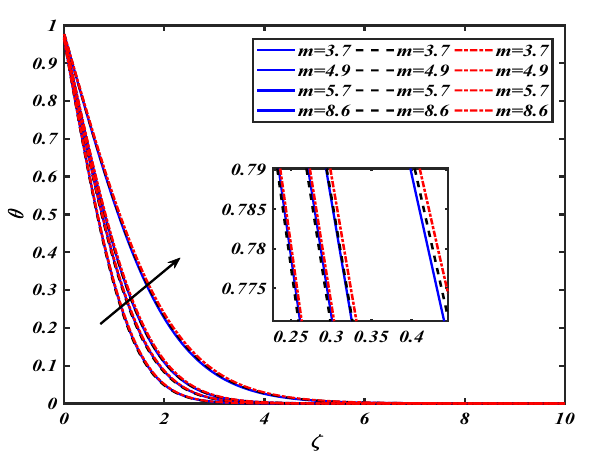
Figure 15. Pictogram of m via θ .